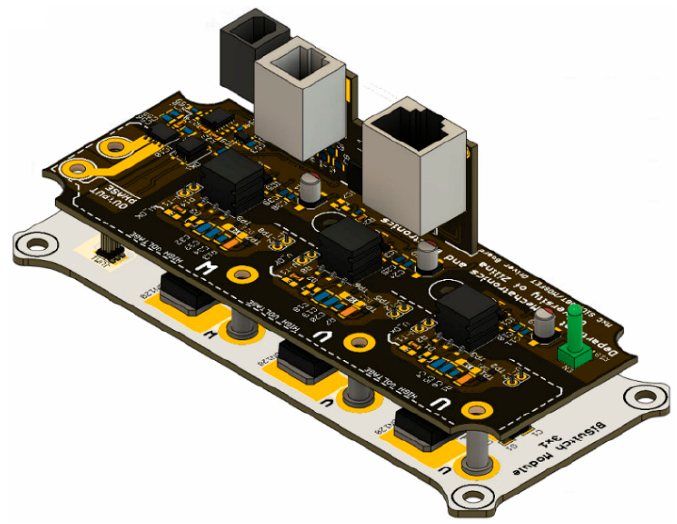
Figure 8. Cross-sectional look at the power and driver boards connection. Due to the space limitations on the driver board, the input signal board shown in Figure 2 must be designed on the separated PCB. This board consists of a buck power supply with an operating range from 9 V to 15 V and output power of 10 W. For the interface, three different connectors are used. For the pulse width modulation (PWM) signals, the RJ50 shielded connector is used. This connector transfers six PWM signals, and the remaining wires are used as supply voltage lines. The level shifter shifts input PWM signals to the 5 V level appropriate for the gate drivers. For the current direction and the actual measured current value, the RJ11 connector is used. The value of the output module current is transferred through the differential twisted pair to improve immunity to electromagnetic interference. Finally, the optical TOS-LINK connector is added to the board. Through this interface, the current direction is transmitted too so that the board can transmit the current direction signal in two ways. The optical interface is fast, reliable, and immune to electromagnetic interference, so it is preferred in a disturbed environment. The signal board is mounted perpendicularly to the driver board, so all connectors face upwards. The 3D model of the assembled 3 × 1 matrix converter module is shown in Figure 9.